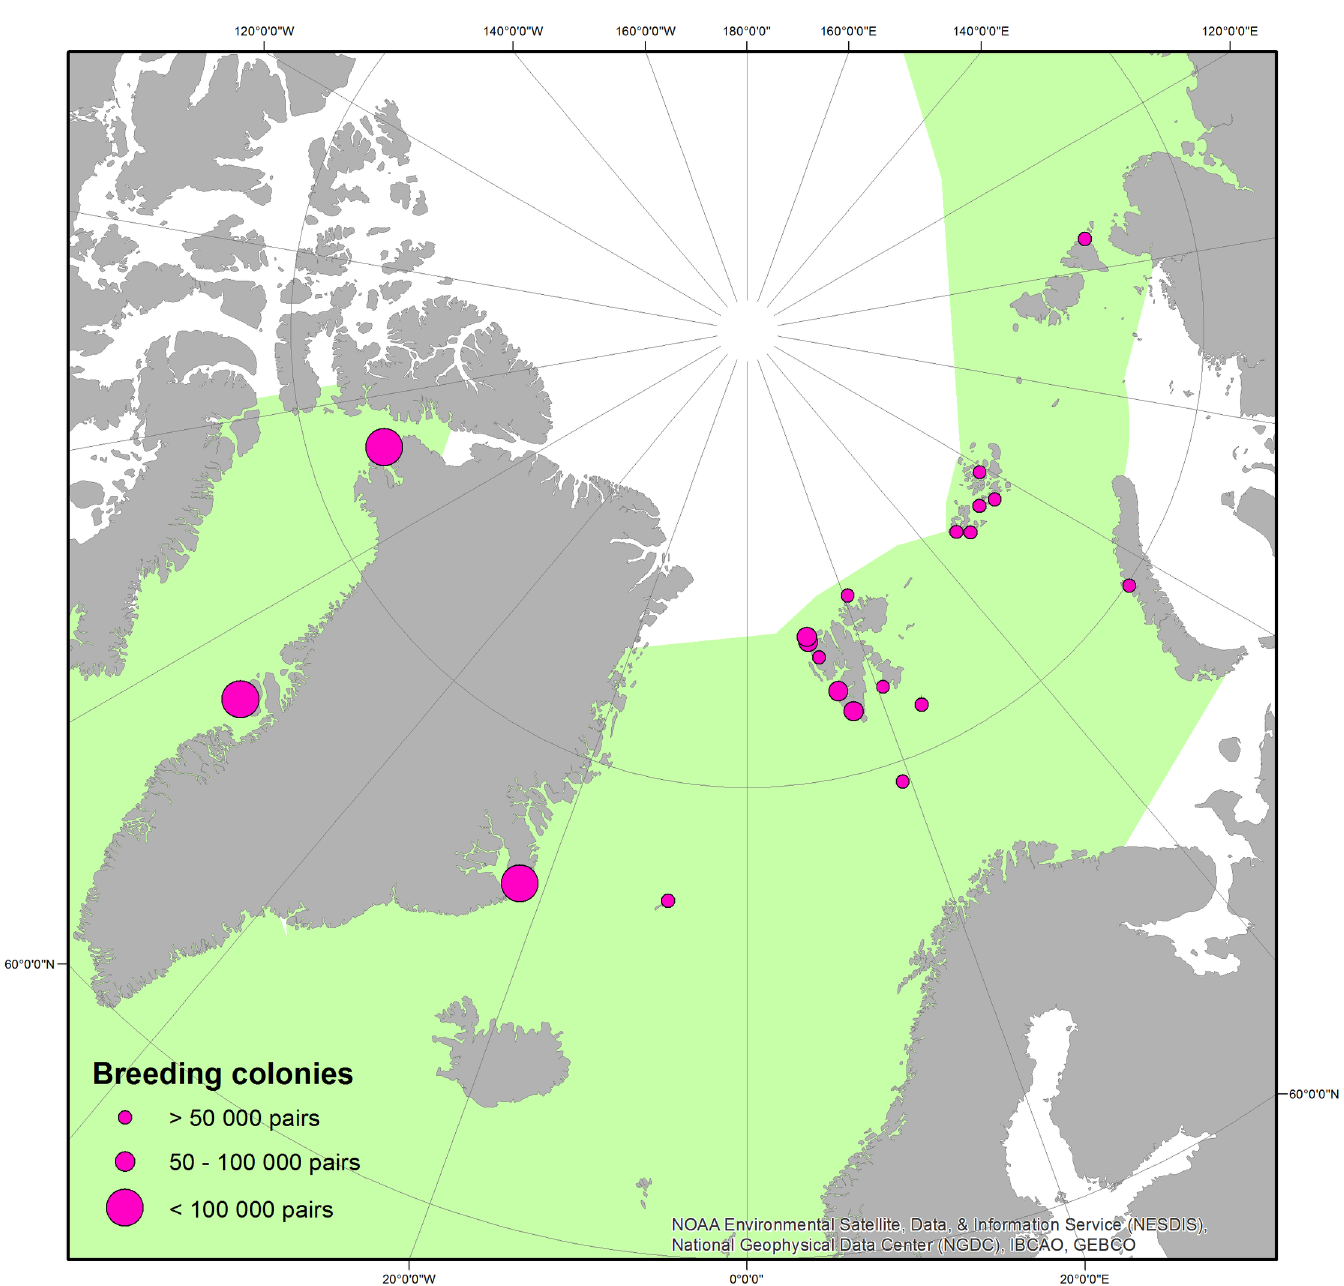
Fig 1. Distribution of foraging areas and breeding colonies of the little auk. Frame indicates the study area. Green colour represents the range at sea. Dot size corresponds to colony size (number of breeding pairs). Source of data summarized in Table 5. Background (bathymetry and contour map): NOAA Satellite Maps.